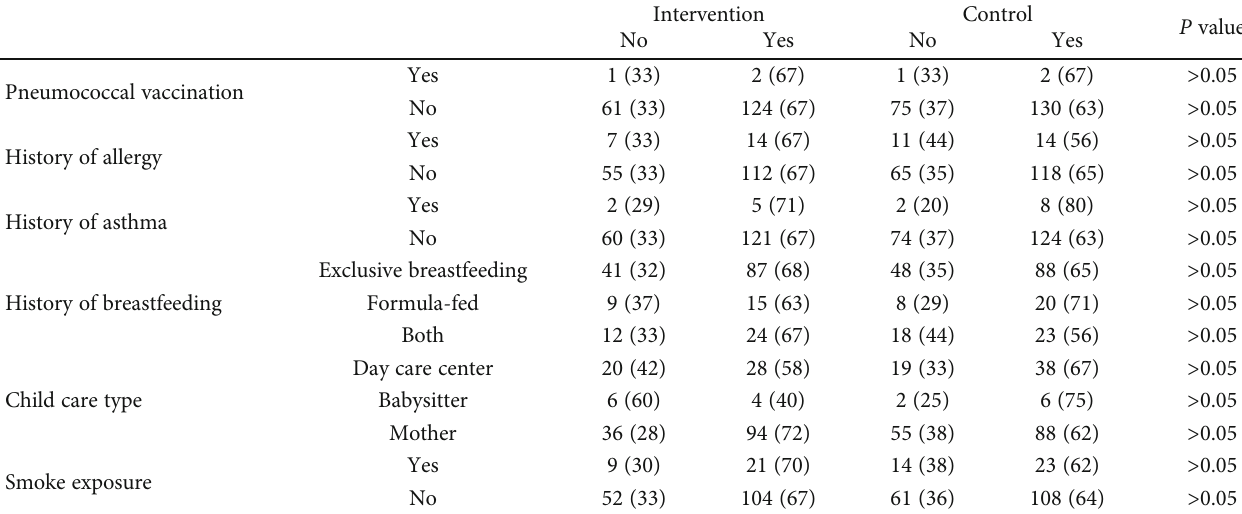
Table 5: Association between AOM recurrence after 3 months and di ff erent